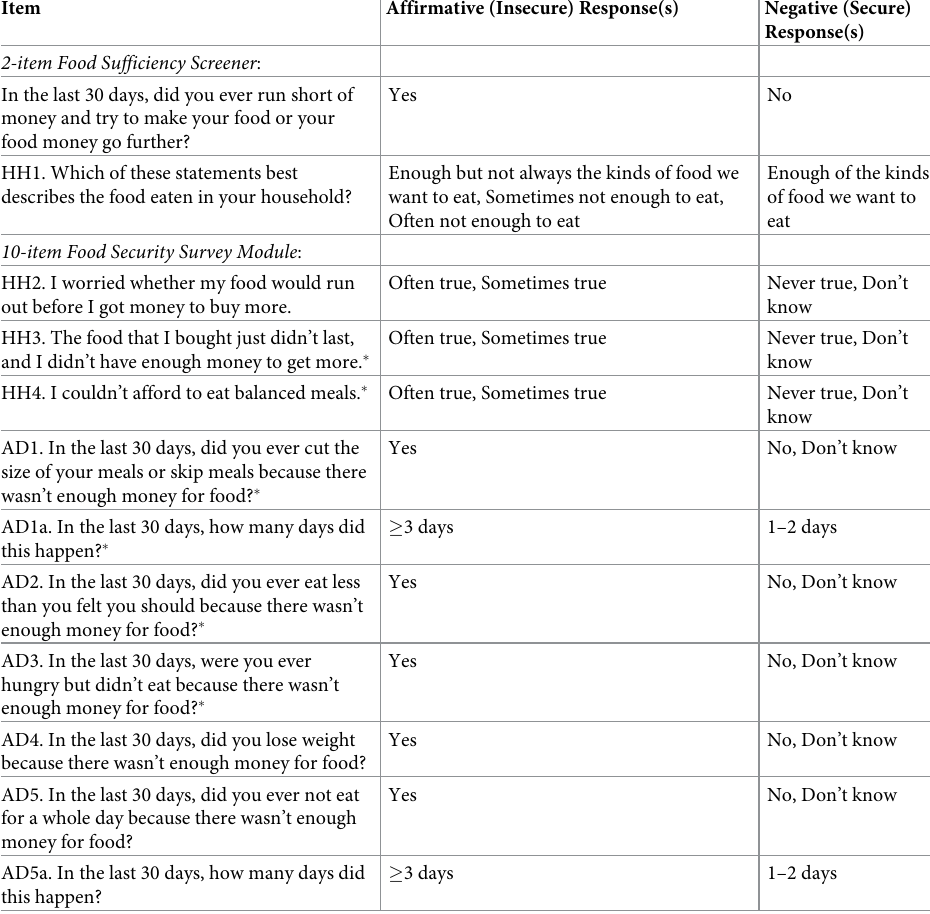
Table 1. Food security questionnaire items and coding of response options as insecure or